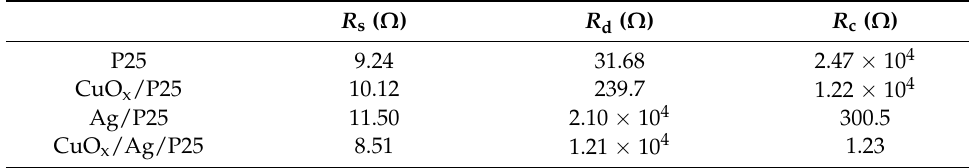
Table 1. EIS fitting results of photoanode films.